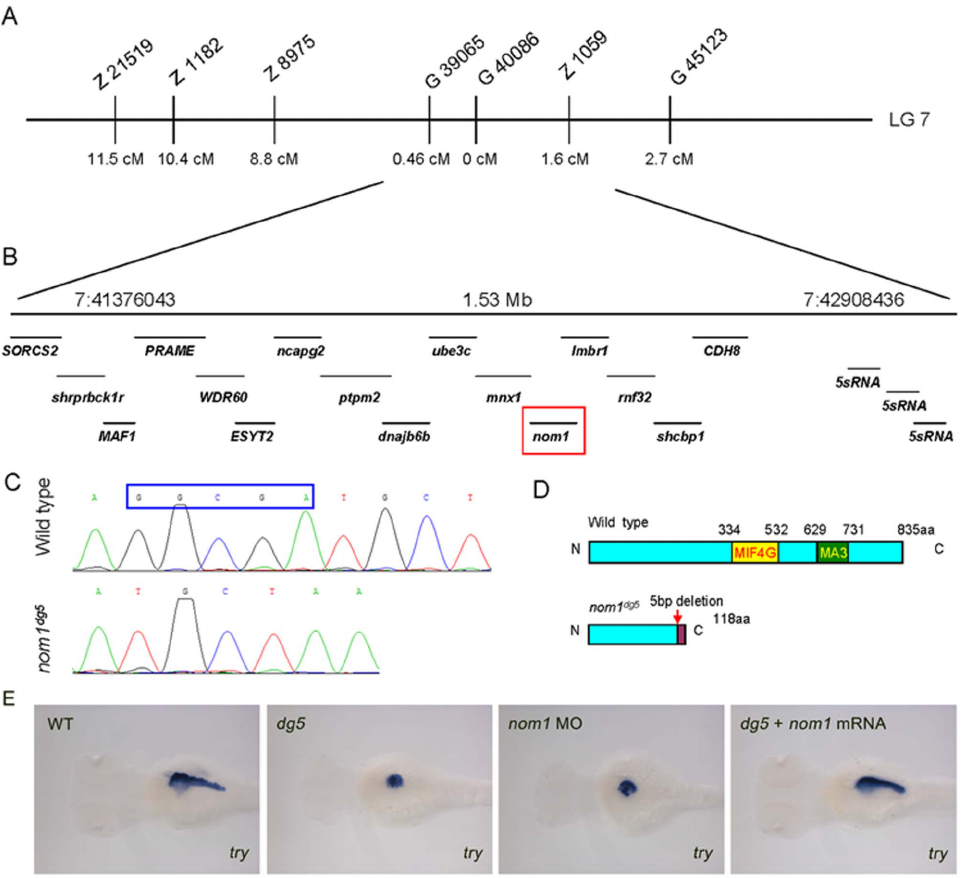
Figure 2. dg5 encodes zebrafish nom1 . (A) Chromosome 7 is linked to the dg5 locus, the cM distance of different SSLP markers to dg5 locus is marked. (B) The region between markers G39065 and Z1059, contains 16 annotated genes (B). (C) Sequencing shows that nom1 from dg5 mutant has a 5-bp nucleotide deletion, producing a truncated nom1 protein. (E) nom1 ATG-MO injected embryos show the same decreased try expression level as compared to dg5 mutant and zebrafish nom1 mRNA can rescue try expression. Dorsal views, anterior to the left.